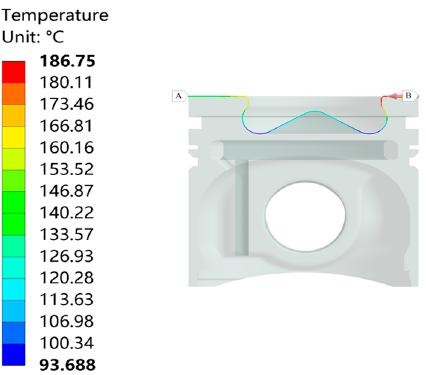
Figure 14. Path AB of conventional Al-Si piston.